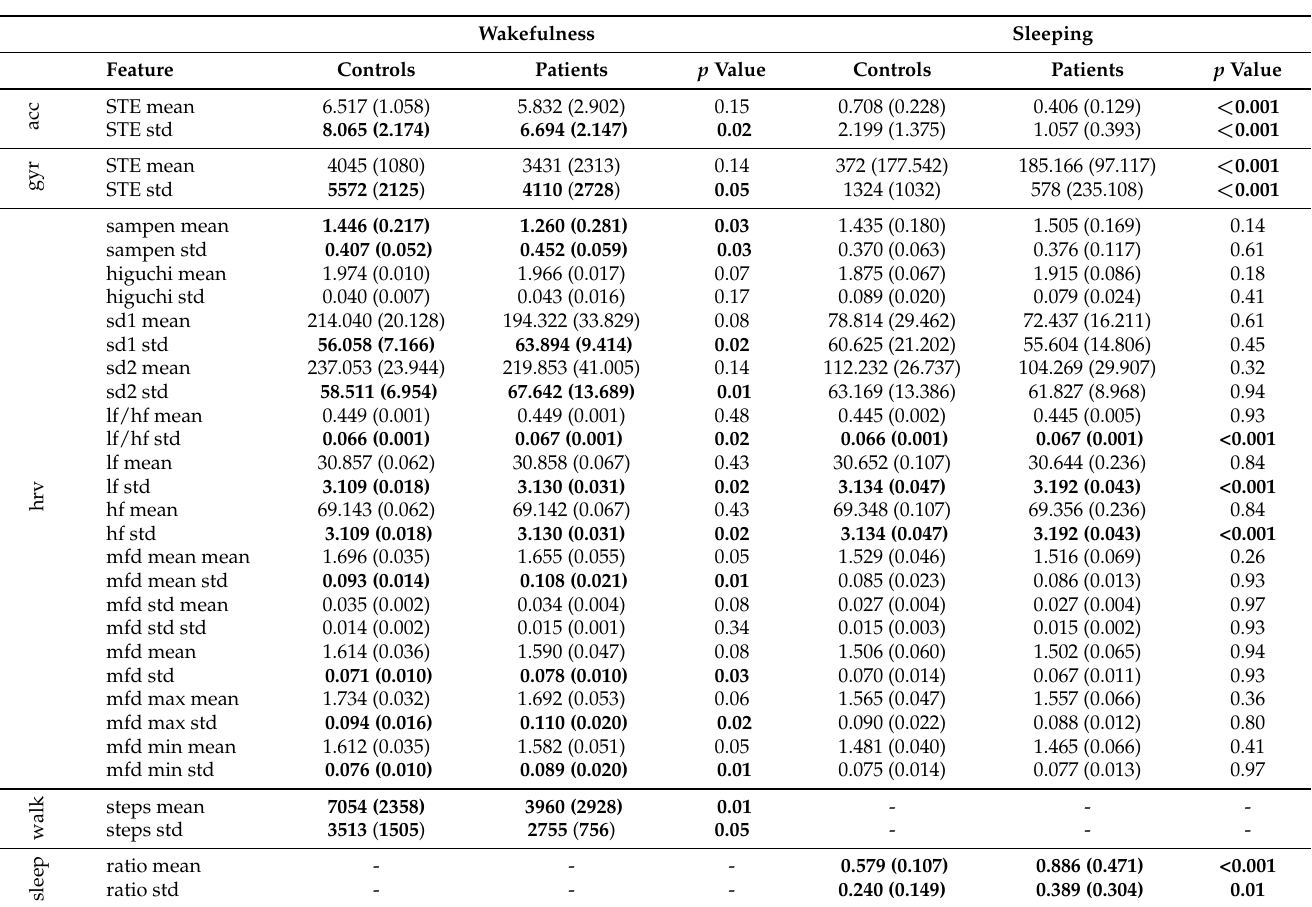
Table 4. Statistical difference analysis using Mann-Whitney U-tests with BH correction in each state (wakefulness, sleeping. Bold values denote significance at the 95% confidence levels. For each group the median and the IQR (in parenthesis) are shown for each feature.